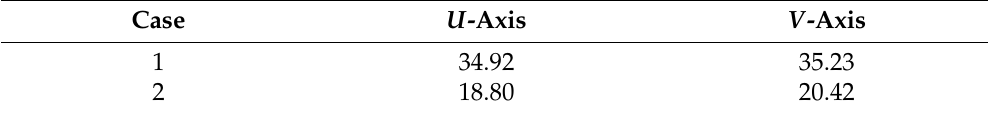
Table 6. Simulation 3: RMS errors.